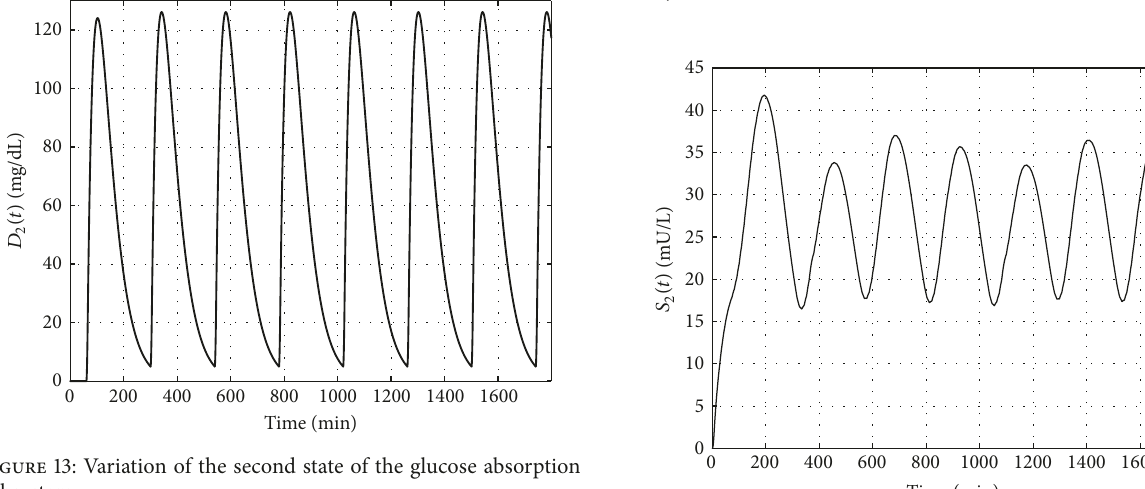
Figure 14: Variation of the first state of the insulin absorption subsystem.